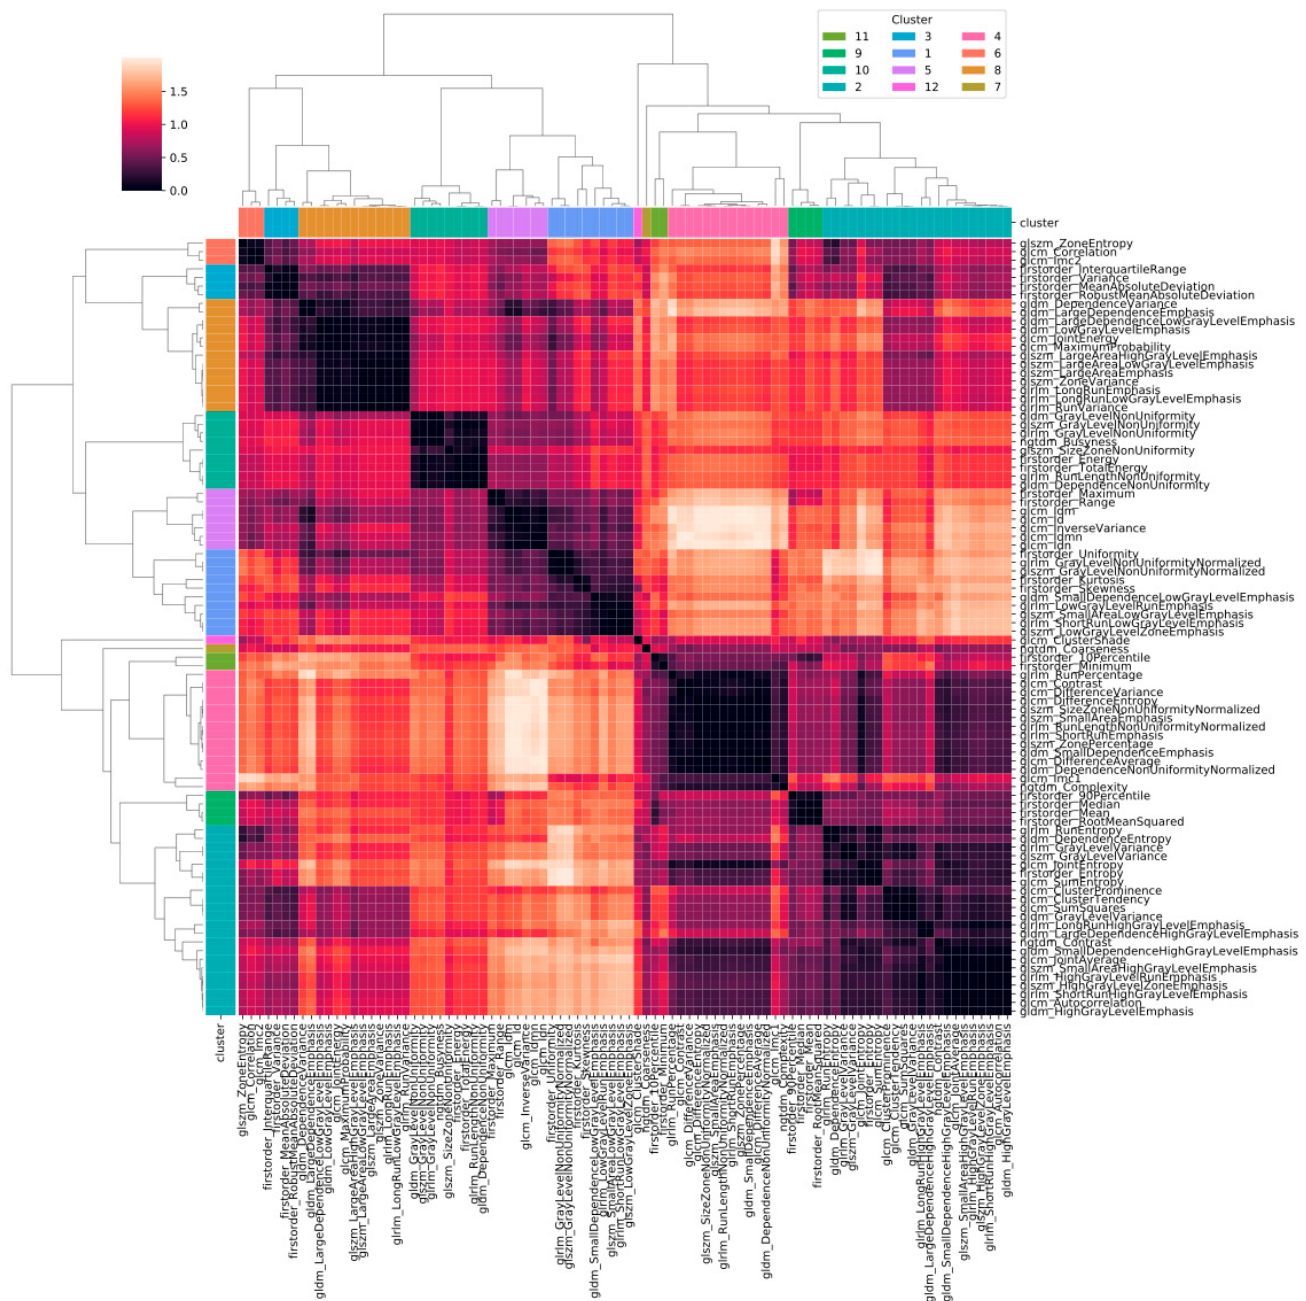
Figure 2. Heatmap of the correlation between pairs of radiomic features. Values in the heatmap correspond to (1 − r), where r is Pearson’s correlation coefficient .